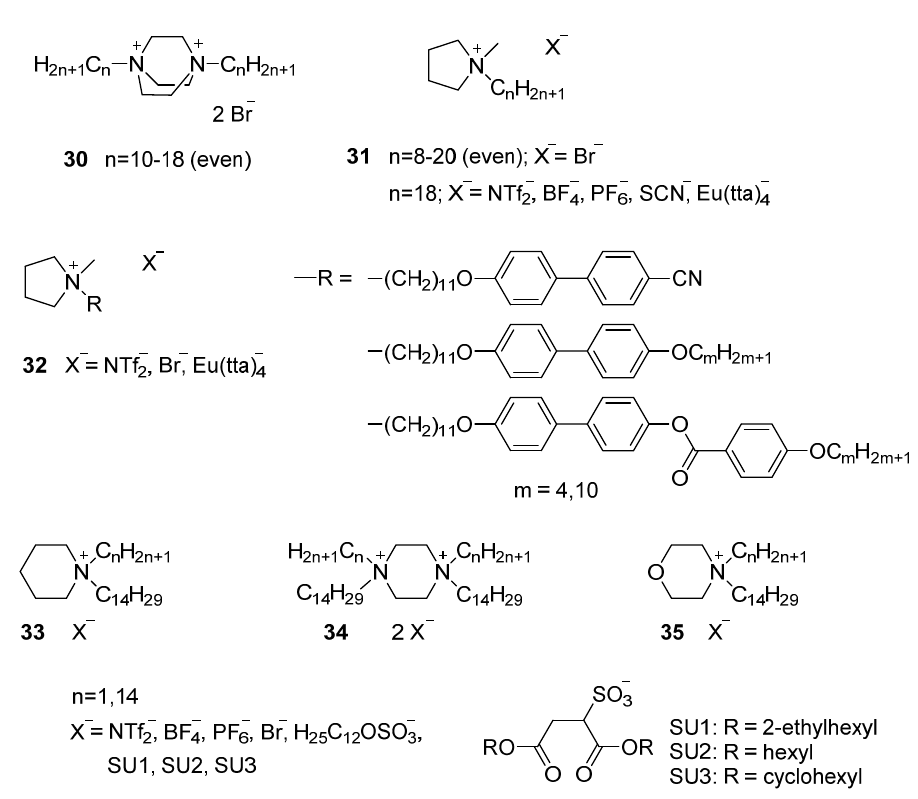
Figure 7. ILCs based on aliphatic heterocyclic cations ( 30 – 33 , 35 ) and dications ( 34 ), substituted with one or more aliphatic tails or with classical thermotropic mesogens. one or more aliphatic tails or with classical thermotropic